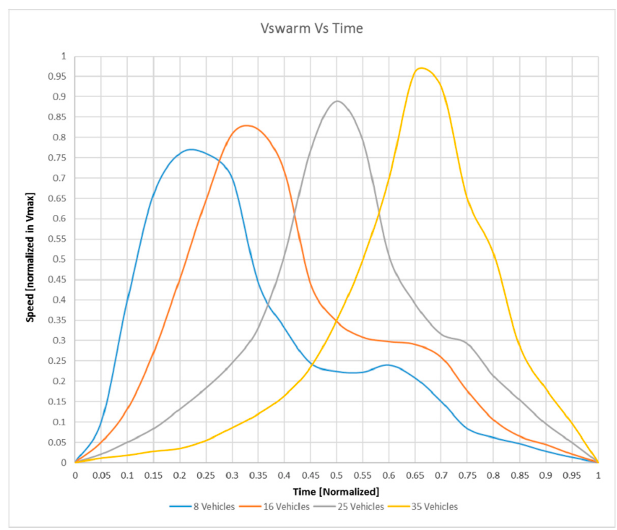
Figure 5. Velocity of the swarm vs. time: Parametric curves with 8, 16, 25, and 35 vehicles (time and speed are normalized).